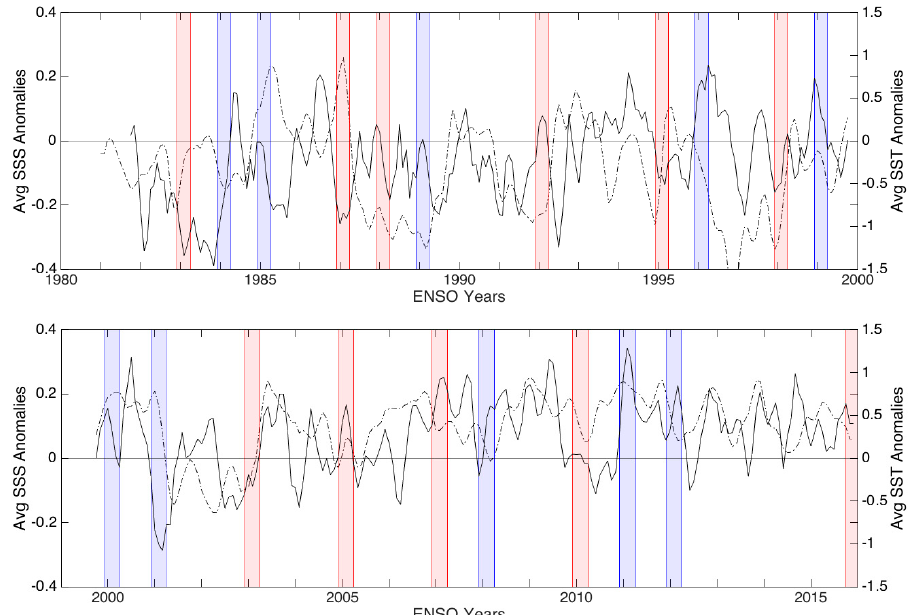
Figure 10. Time series from 1981–2016 for monthly box-averaged (37°–45°S, 10°–20°E) AVHRR SST (solid line) and SODA SSS (dashed line) anomalies. ENSO events are represented during their peak (January–March) by vertical shaded bars (red for El Niño and blue for La Niña).